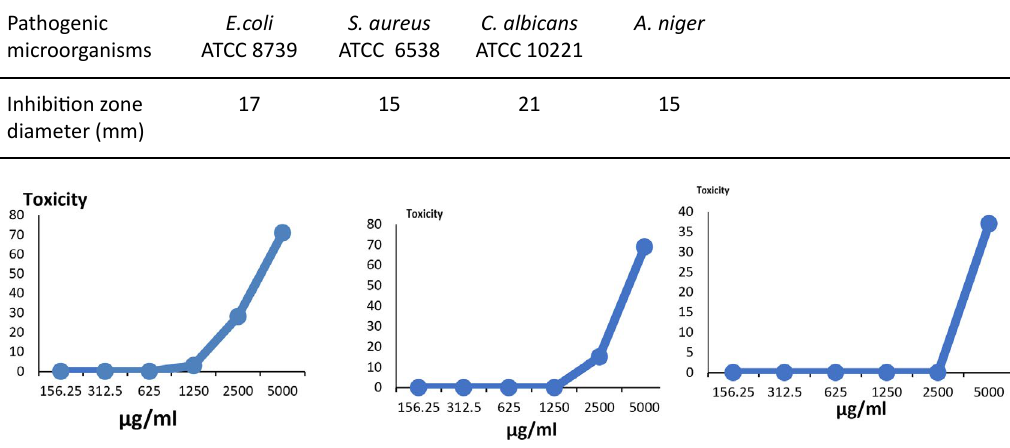
Table 7. Antimicrobial activity against other pathogenic microorganisms Pathogenic